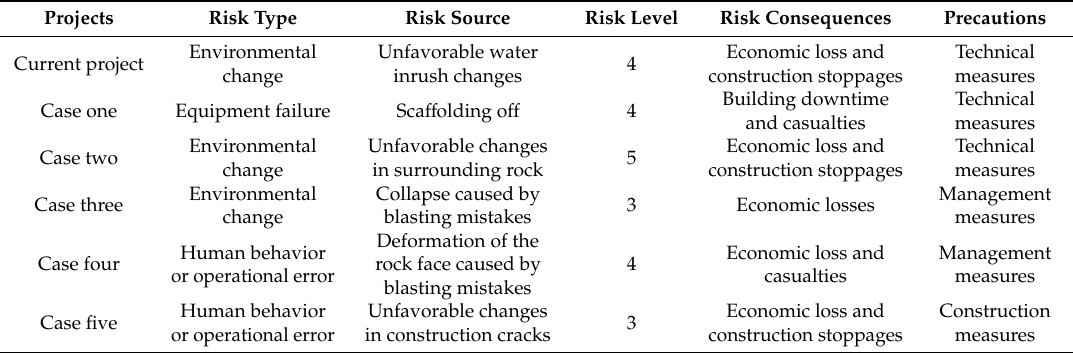
Table 6. Risk attribute indicators of the target case and historical cases in the case